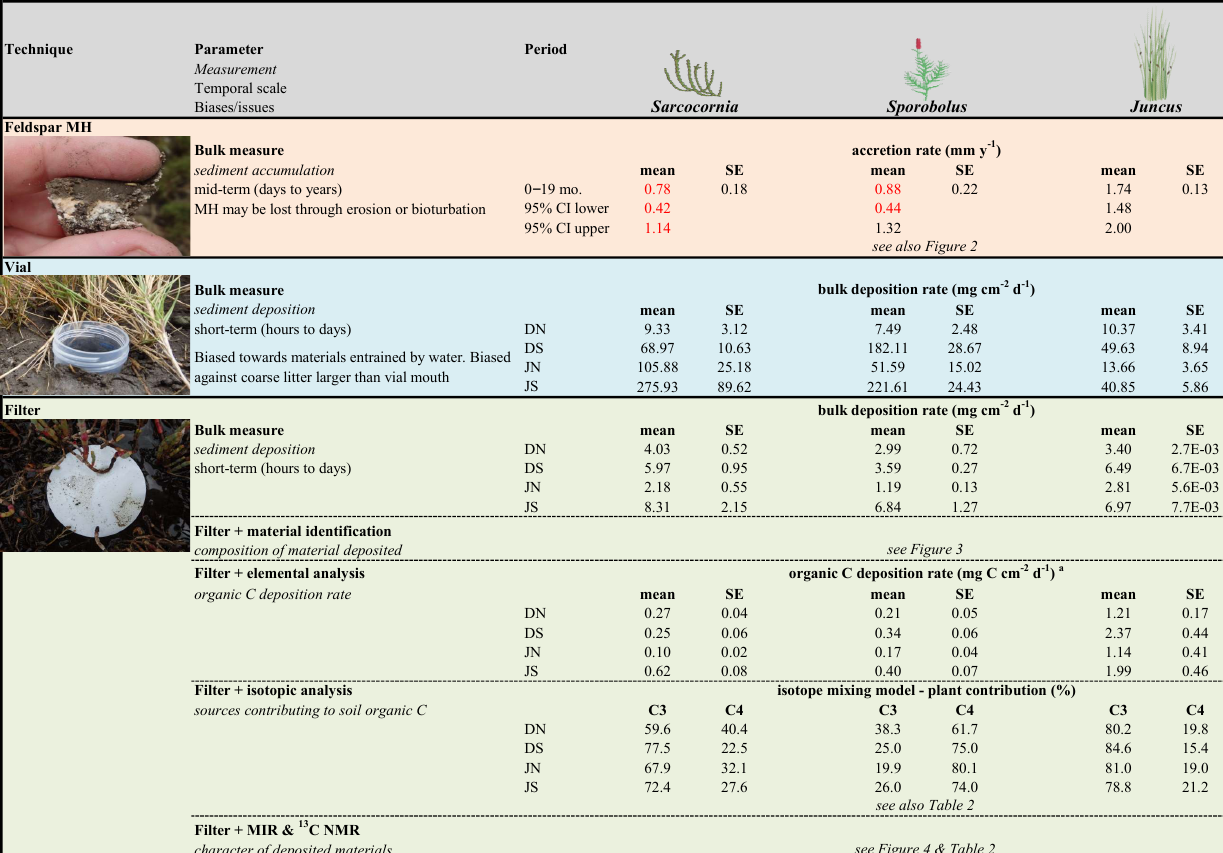
sition on filters varied among vegetation assemblages ( F 2 , 30 . 85 = 48.82, P = 0.004), with significantly lower de- position in Sporobolus plots relative to both Sarcocor- nia (Bonferroni-adjusted P value = 0.010) and Juncus (Bonferroni-adjusted P value = 0.023) plots across all tidal events (Fig. 3, Table 1). In contrast to the vials, there was no clear relationship between bulk material retained on filter papers and plot surface elevation during either of the neap or spring tidal events (Fig.